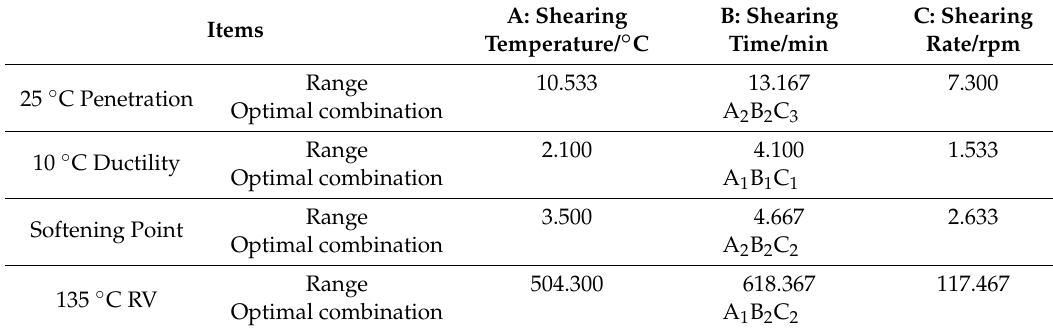
Table 5. OATS Analysis Results.